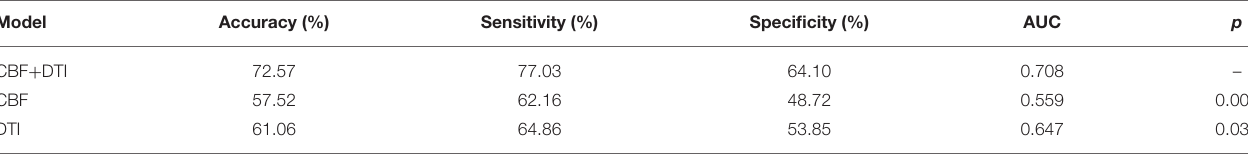
TABLE 2 | Classification performance of SLR classifiers using diffusion features, CBF features, and their combined features. Model